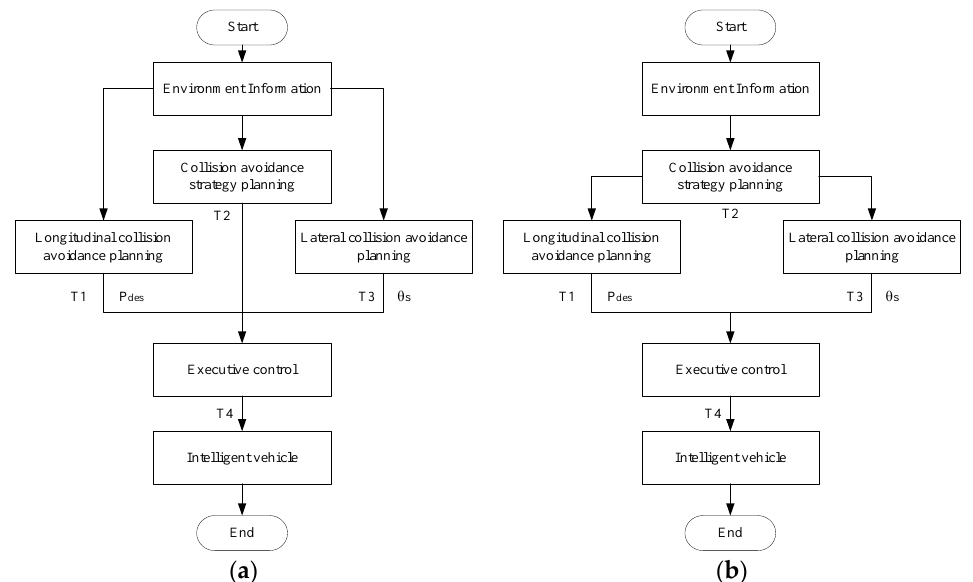
Figure 6. Active collision avoidance system control method: ( a ) Distributed coordinated control system; ( b ) Sequential control system.